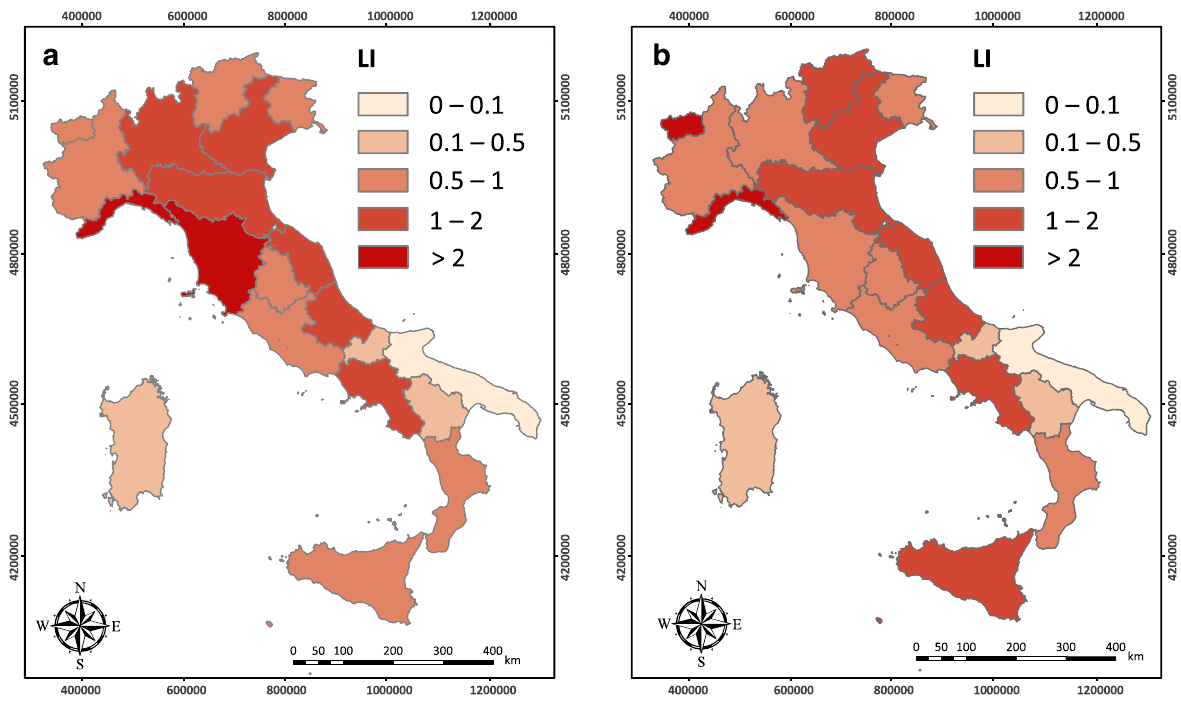
Fig. 8 Values of the Landslide Index (LI) in the 20 Italian regions, comparison between landslide inventories: ( a ) FraneItalia, ( b )